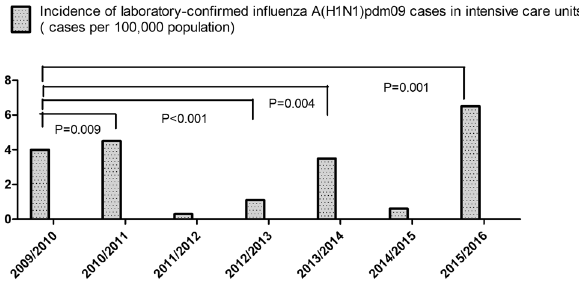
Figure 2. Incidence of laboratory-confirmed influenza A(H1N1)pdm09 cases in intensive care units in the 2009/2010, 2010/2011, 2011/2012, 2012/2013, 2013/2014, 2014/2015, and 2015/2016 seasons ( P value obtained using Poisson regression for the incidence rate ratio) in